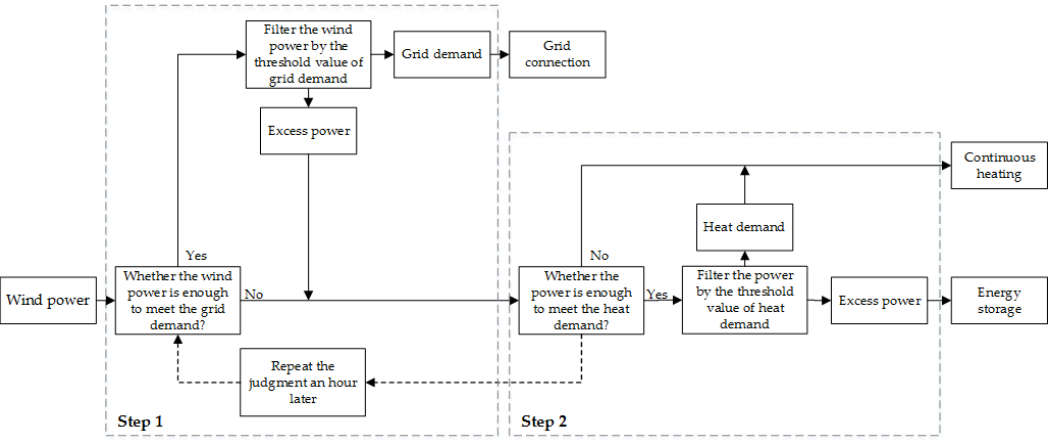
Figure 2. Flow chart about the control scheme in the power controller.